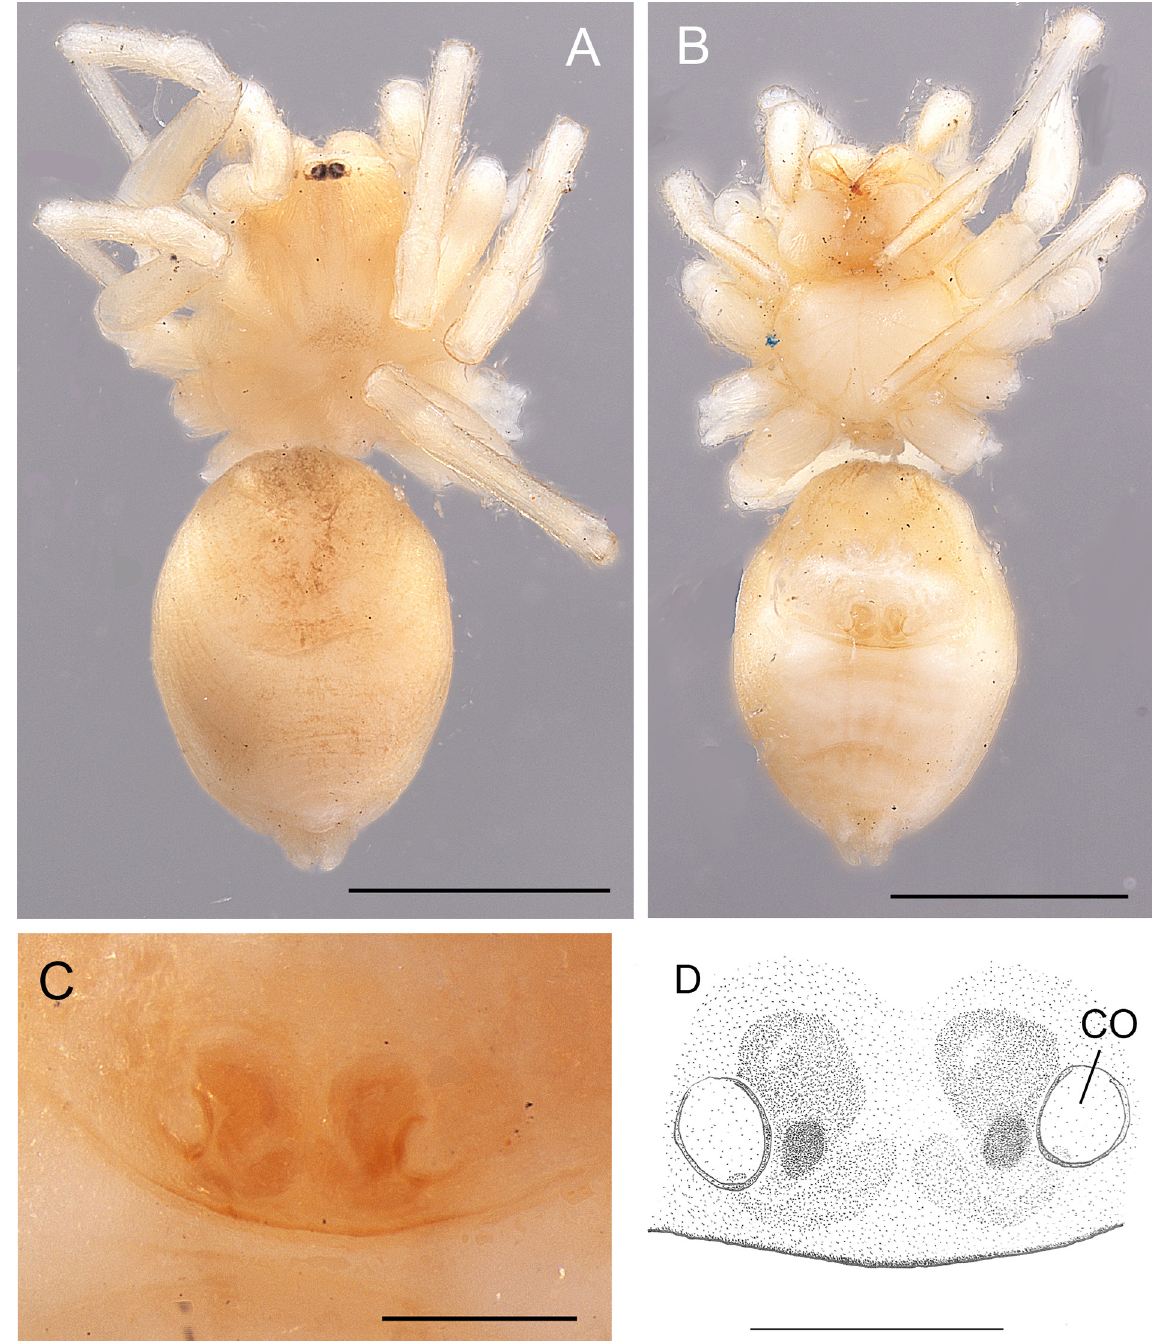
Fig. 5. Andromma aethiopicum Simon, 1893, ♀, paralectotype (MNHN AR1678). A . Habitus, dorsal view. B . Same, ventral view. C–D . Epigyne, ventral view. Abbreviation: CO = copulatory opening. Scale bars: A–B = 1 mm; C–D = 0.2